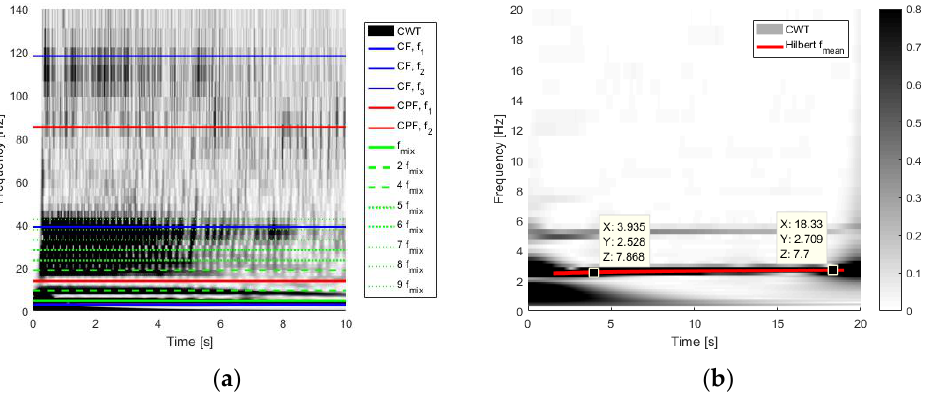
Figure 22. Correlation between the experimental and the numerical data of attractive magnet system: CWT and Multi-Phi method ( a ) and CWT and Hilbert transform ( b ).